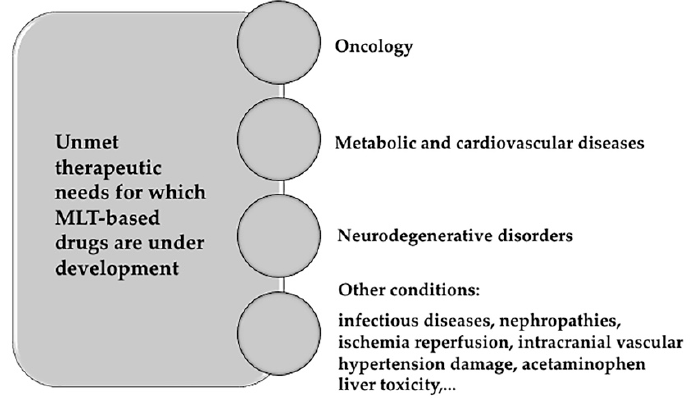
Figure 6. Membrane-Lipid Therapy molecules are currently being developed for several medical